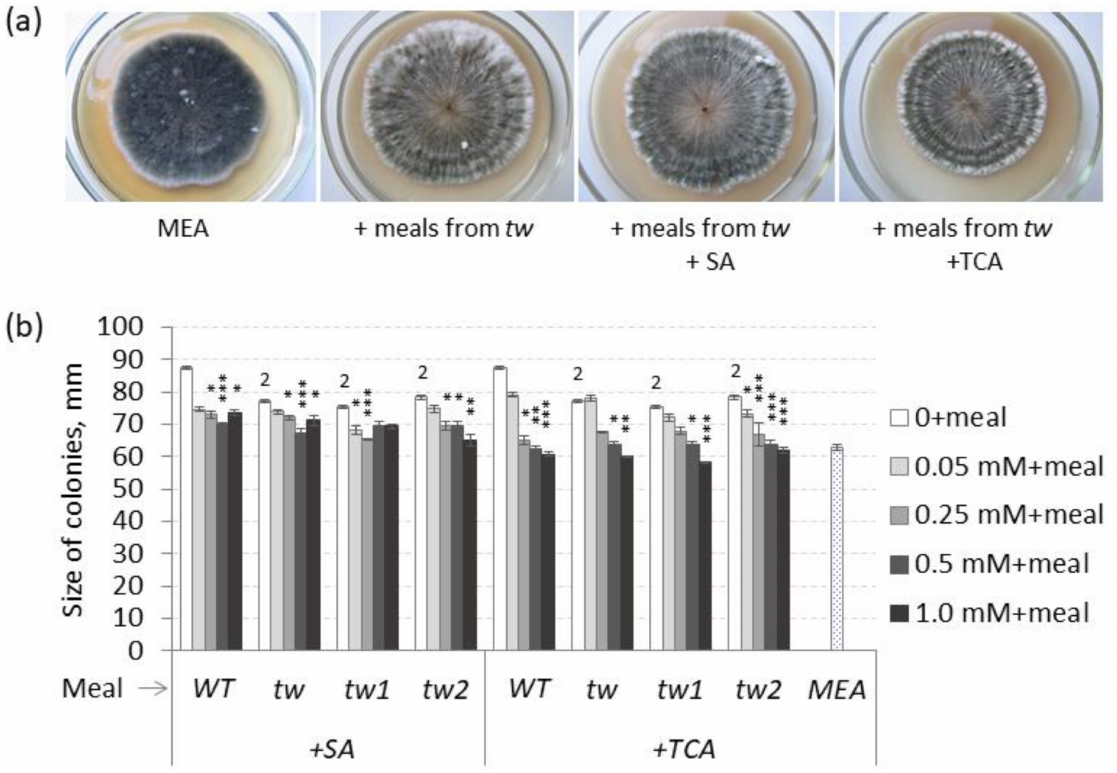
Figure 5. Effects of salicylic acid (SA) and trans -cinnamic acid (TCA) on the growth of Bipolaris sorokiniana after 7 days of growth on medium containing meal from tw . ( a ) The morphology of B. sorokiniana colonies grown on MEA media with different supplements. ( b ) Size of the colonies 7 days after inoculation. MEA, malt extract medium. Grain was produced in 2013, and the experiment was performed in 2014. The asterisks represent significant differences (* p < 0.05; ** p < 0.01; *** p < 0.001) between the control and the SA or TCA treatment. The numbers denote significant differences ( 2 p < 0.01) between the controls of the tw -type mutant and the WT